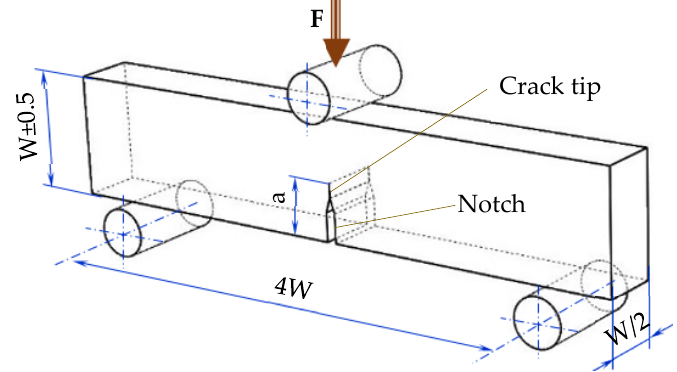
Figure 2. Geometrical parameters of the Single Edge Notch Bend (SENB) sample according to [21].